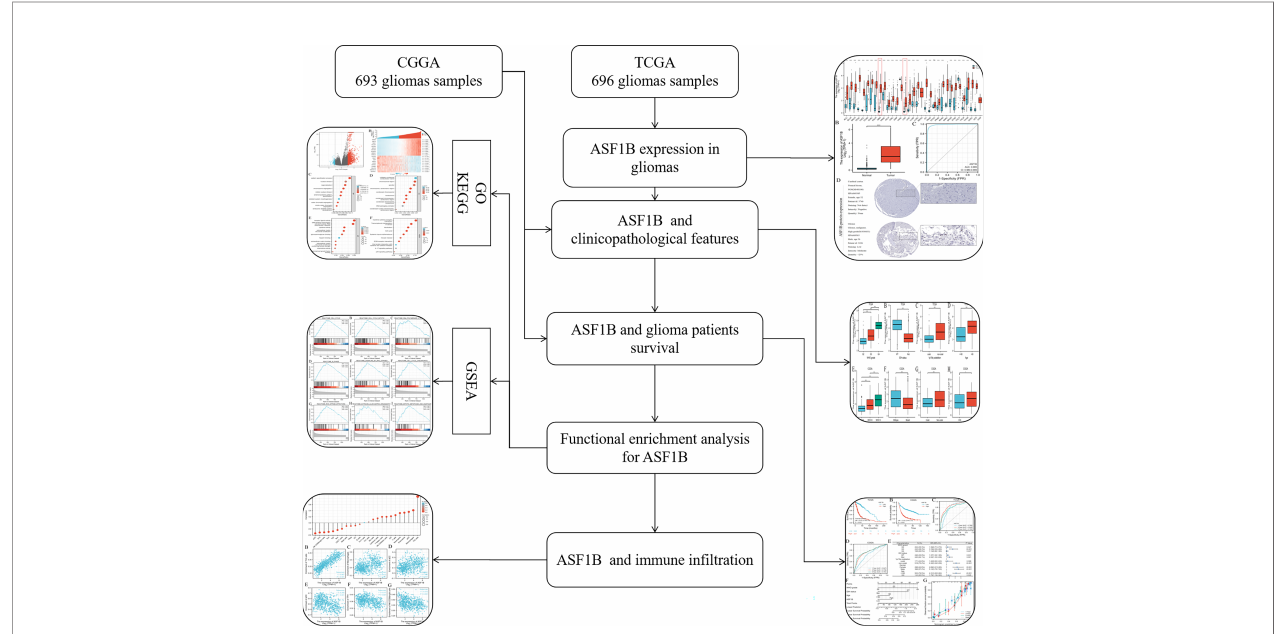
FIGURE 1 | Flowchart of analysis of ASF1B in